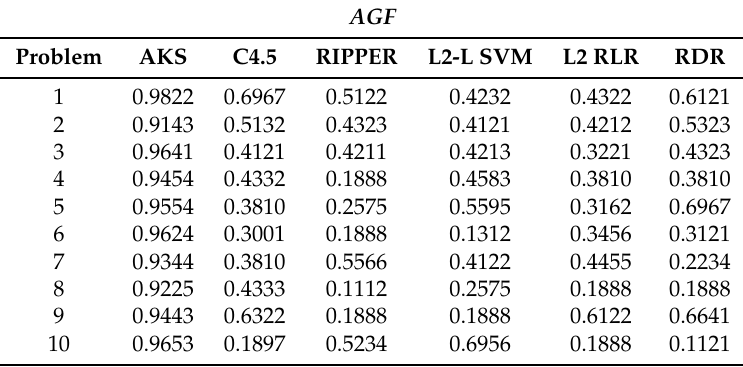
Table 17. Comparison results on the dataset in [4] and Table